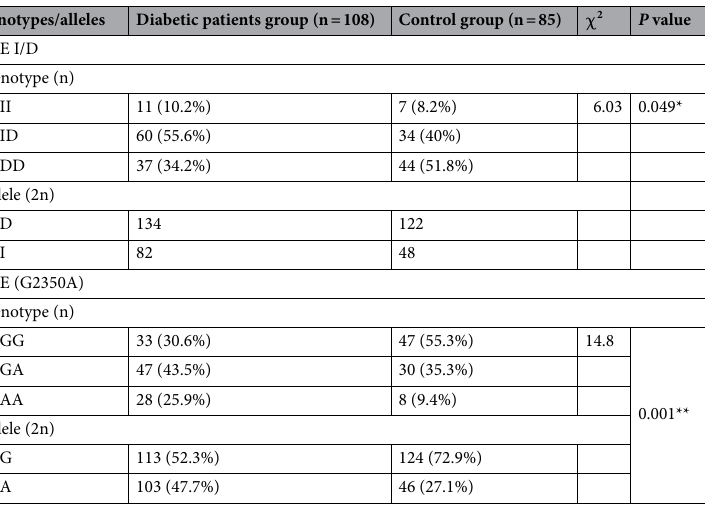
Table 3. Genotypes and allelic frequencies of ACE I/D and ACE G2350A genes in diabetic Patient and control groups. **High significant p < 0.001, *significant at p < 0.05.